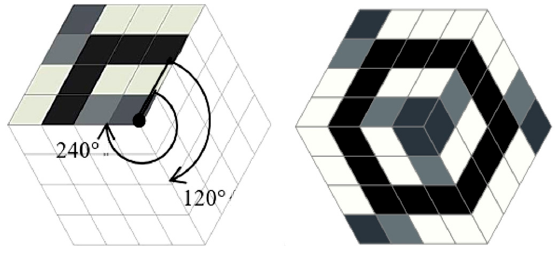
Figure 9. Basic structure and the cell of periodicity Y I exhibiting homogenized exact isotropic properties of a periodic body.